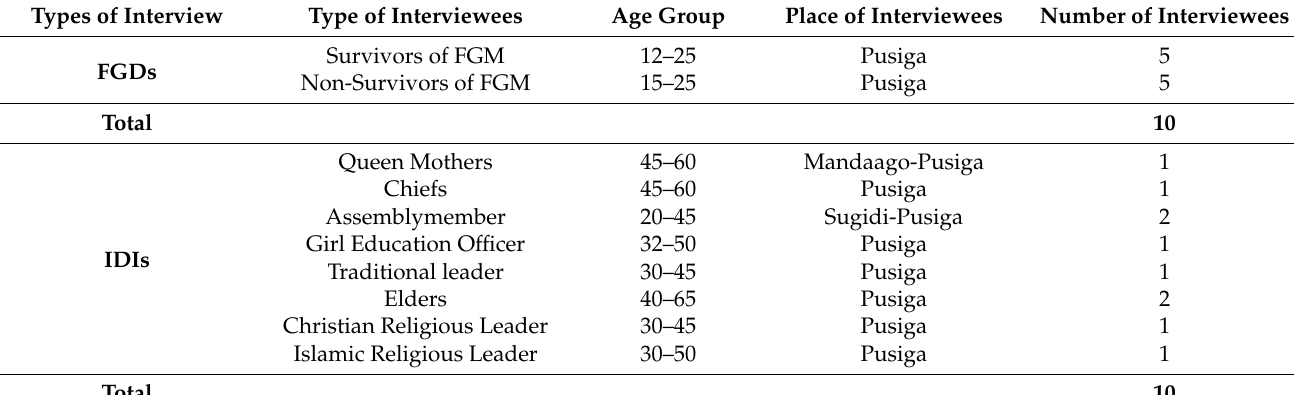
Table 1. Socio-Demographics of